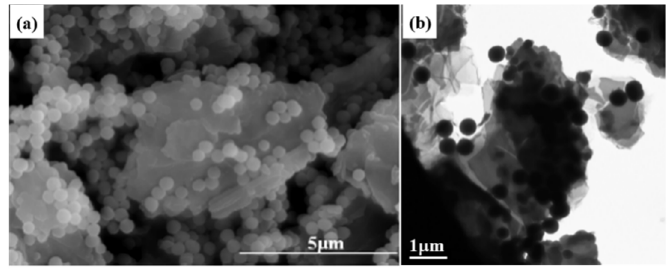
Figure 6. ( a ) SEM and ( b ) TEM images of Si-GO [66].